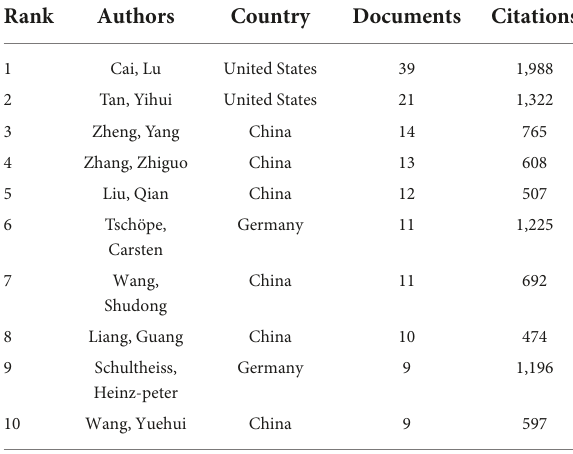
TABLE 4 Core authors on inflammation in diabetic cardiomyopathy